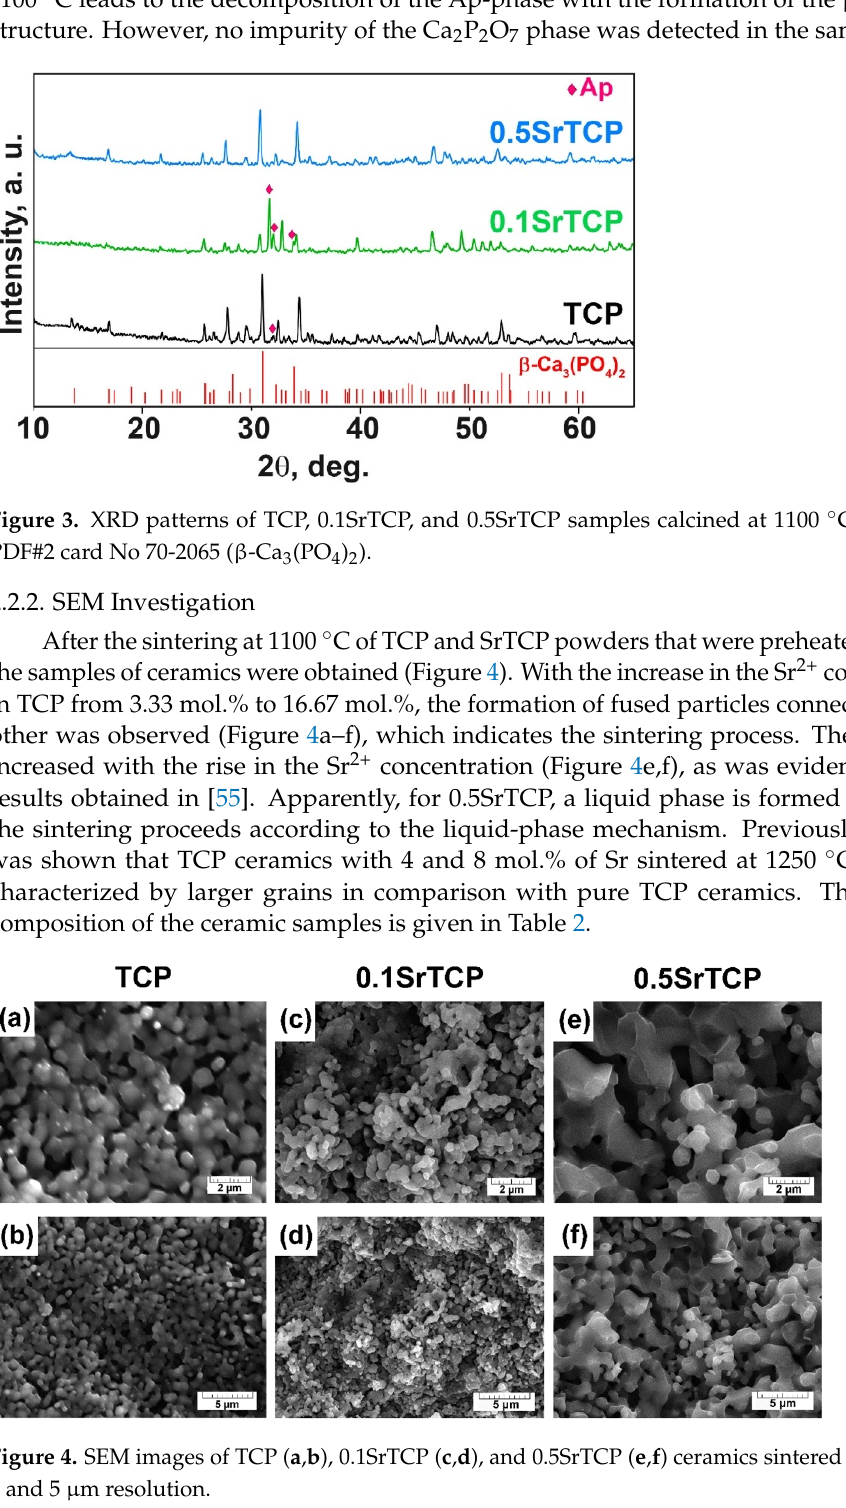
Figure 2. SEM images of TCP ( a , b ), 0.1SrTCP ( c , d ), and 0.5SrTCP ( e , f ) powders calcinated at 900 °C at 10 and 50 μ m resolutions.